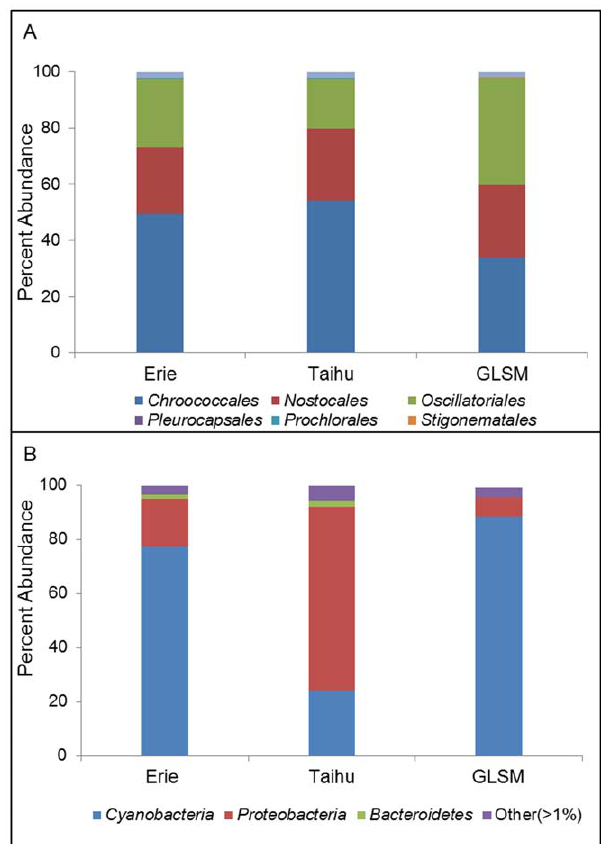
Figure 3. Identity of bloom-associated microbial community members. A) Percent abundance of orders belonging to the Cyanobacteria phylum. Abundance is a percentage of reads annotated as Cyanobacteria from each metagenome. B) Distribution of bacterial phyla in each metagenome. Abundance is a percentage of total bacterial reads in each metagenome. Phyla with less than 1% total abundance were grouped in the ‘‘Other’’ category.